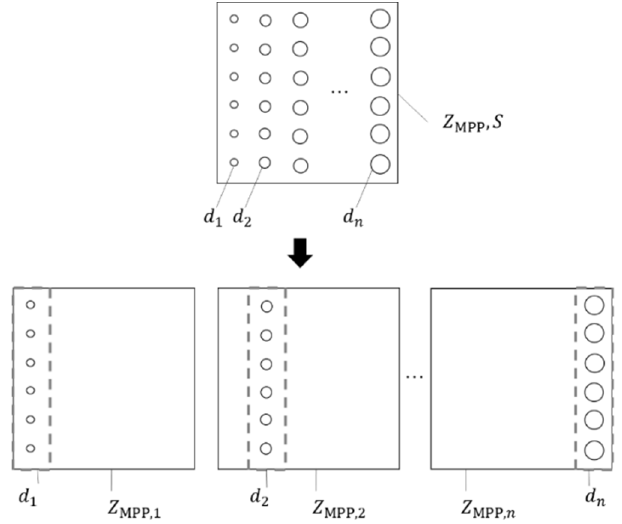
Figure 7. Diagrams of the hypothetical MPPs. The upper MPP is the original MPP, and the lower MPPs are the hypothetical MPPs, which have holes of each diameter only in surface area S .